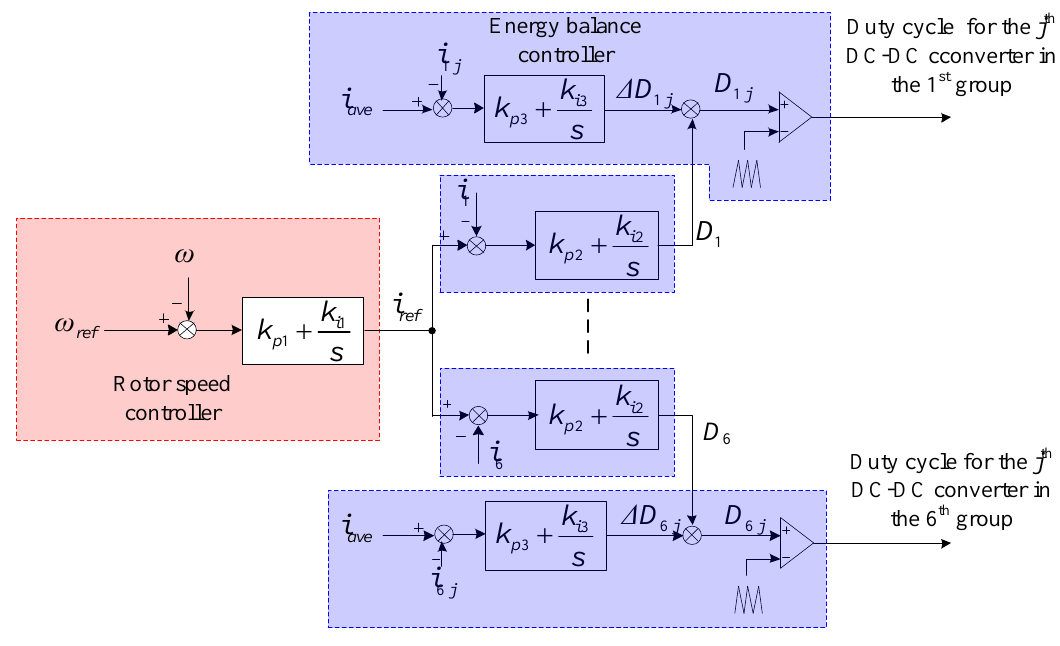
Figure 3. The scheme of the maximum power point tracking (MPPT) controller.